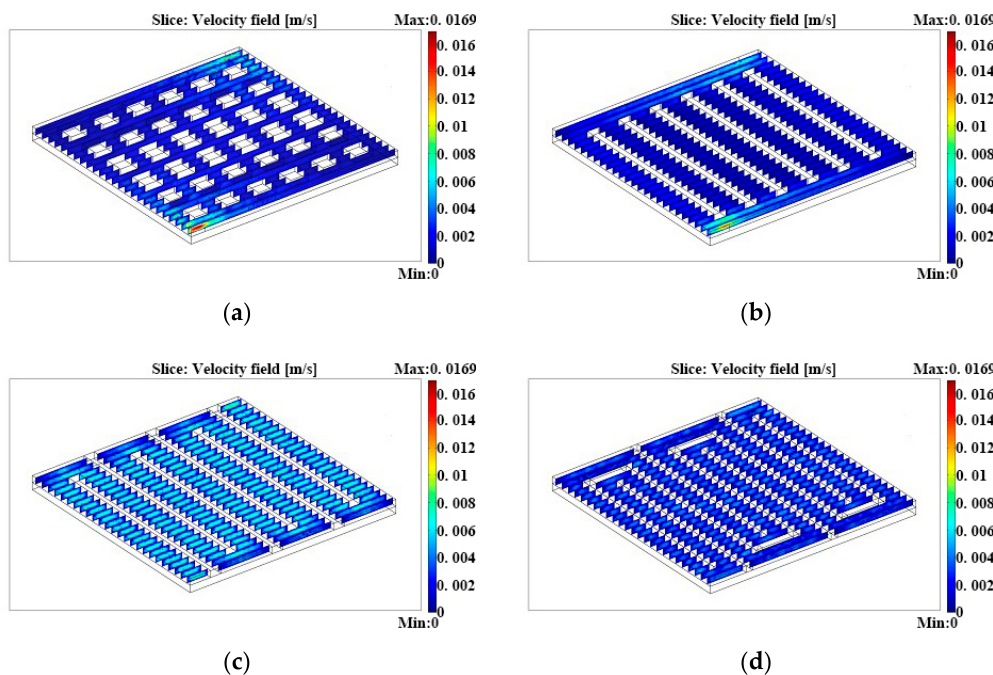
Figure 3. Flow rate distributions in ( a ) grid flow fields, ( b ) parallel flow fields, ( c ) single ‐ serpentine flow fields, and ( d ) double ‐ serpentine flow fields.